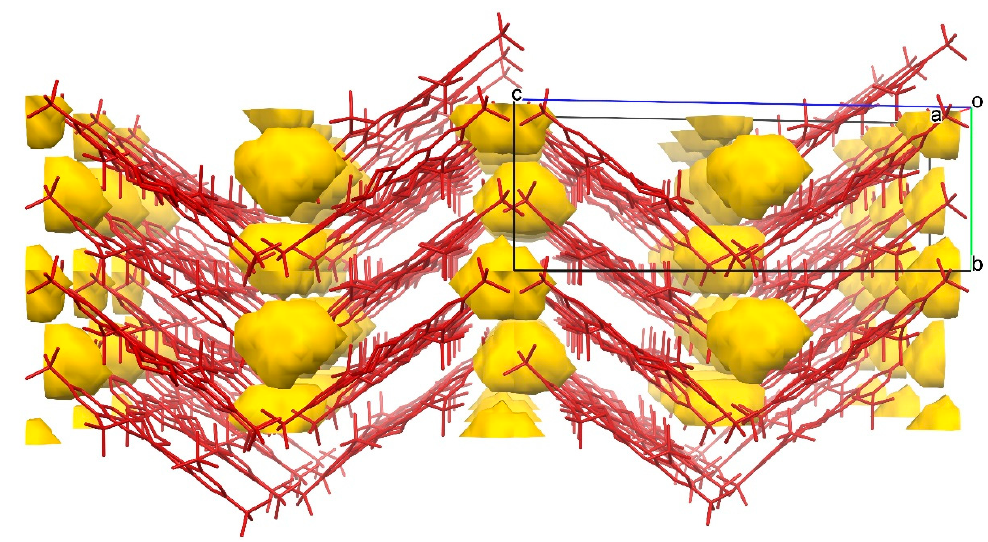
Figure 5. Packing diagram for Co(L R,R ) with voids in yellow (1.2 Å probe radius and 0.7 Å grid spacing). Hydrogen atoms are omitted for clarity.